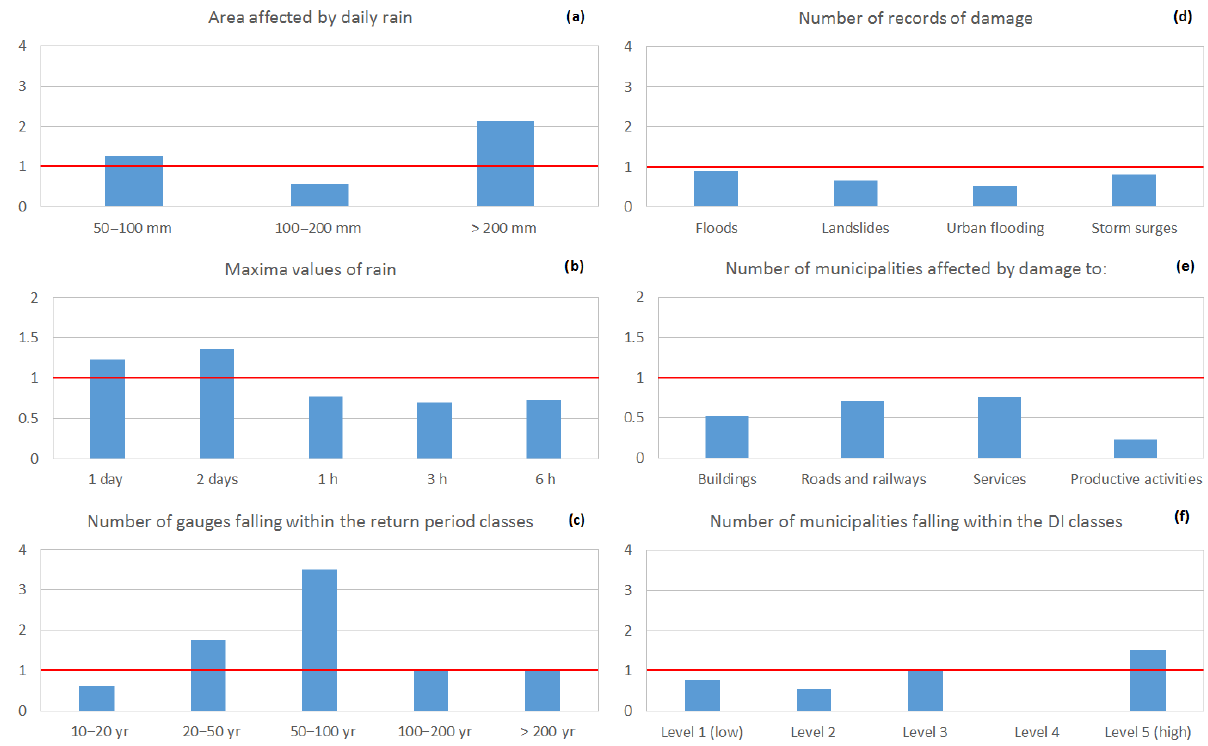
Figure 6. Events comparison by means of the ratio between the 2015 and the 2000 values reported in the titles of diagrams.